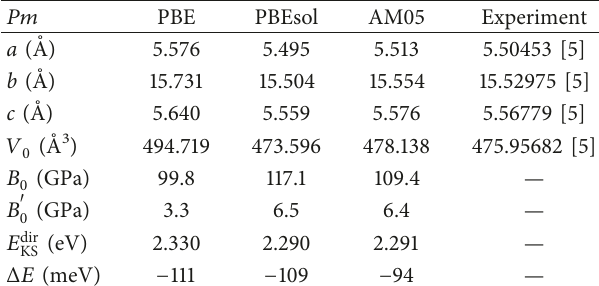
Figure 4: NaNbO 3 dielectric functions calculated using different exchange-correlation potentials. The real (orange) and imaginary (green) parts of the dielectric functions for (a) the conventional PBE functional of Perdew et al. [16], (b) the PBEsol functional revised for solids [18], (c) the AM05 functional [17], and (d) the PBE0 hybrid functional [19]. Table 2: Structural properties of the monoclinic Pm phase of NaNbO 3